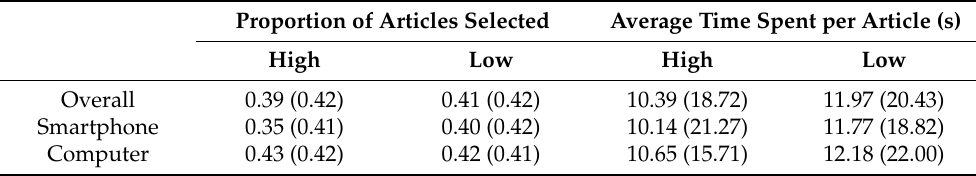
Table 5. Impact of on Social Cues by Browsing Device Condition (Study 2). Proportion of Articles Selected Average Time Spent per Article (s) High Low High Low Overall 0.39 (0.42) 0.41 (0.42) 10.39 (18.72) 11.97 (20.43) Smartphone 0.35 (0.41) 0.40 (0.42) 10.14 (21.27) 11.77 (18.82) Computer 0.43 (0.42) 0.42 (0.41) 10.65 (15.71) 12.18 (22.00)